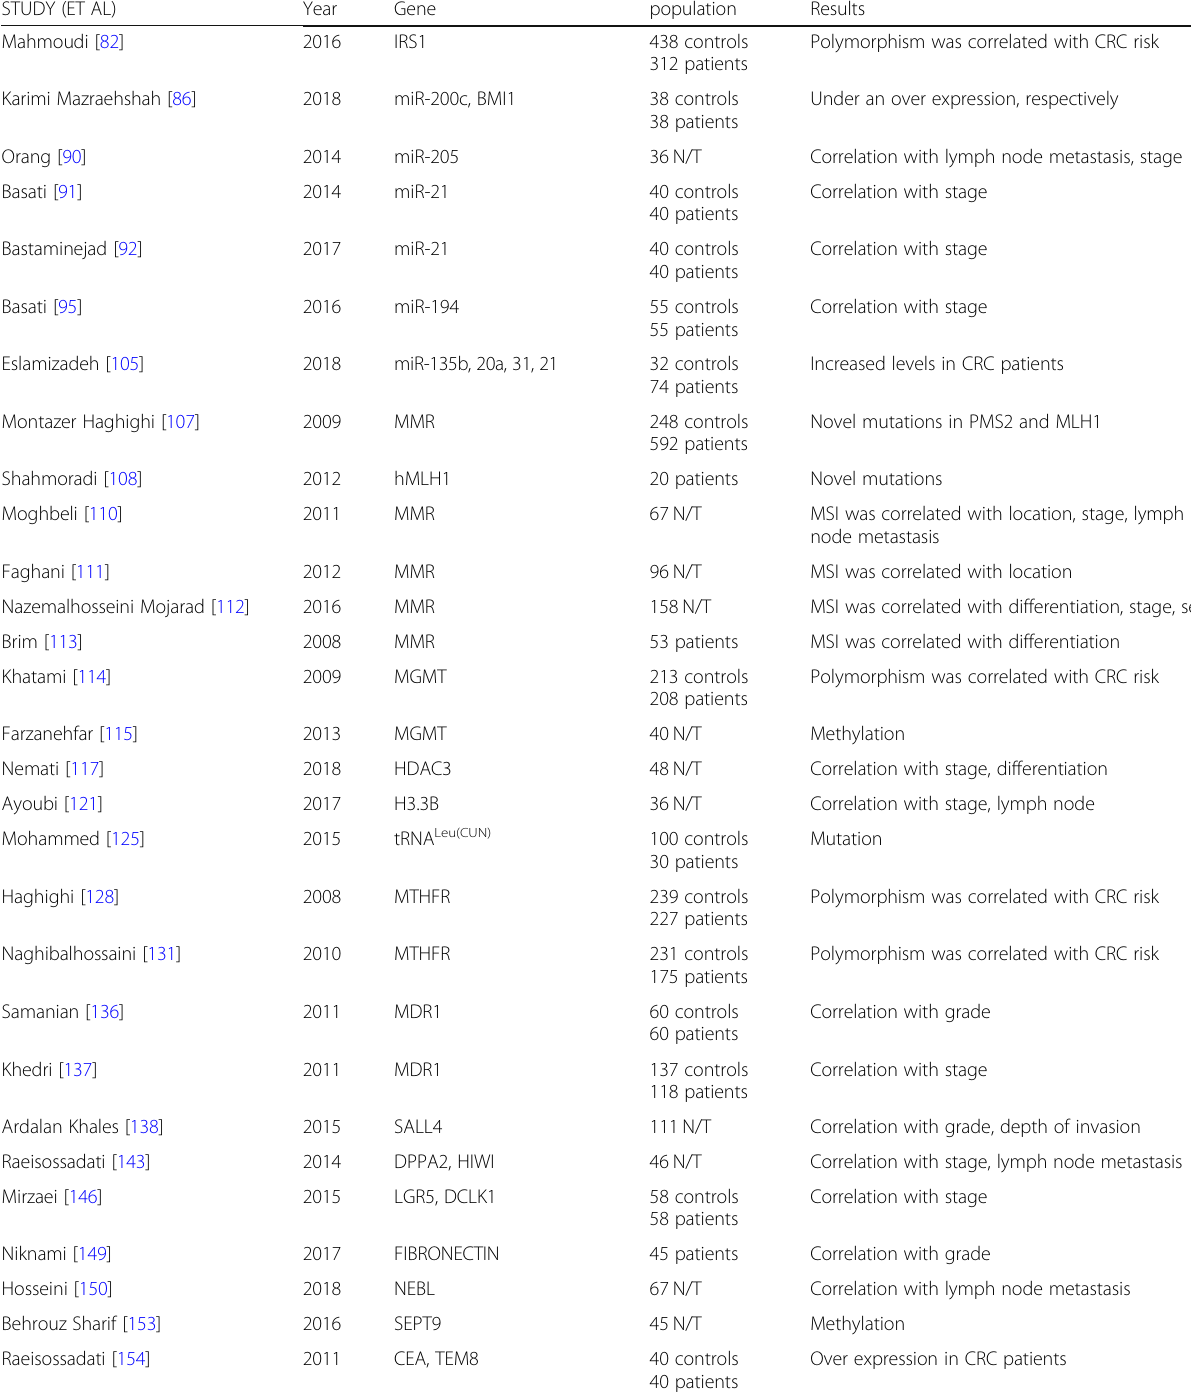
Table 1 All of the involved markers in CRC susceptibility among the Iranian patients